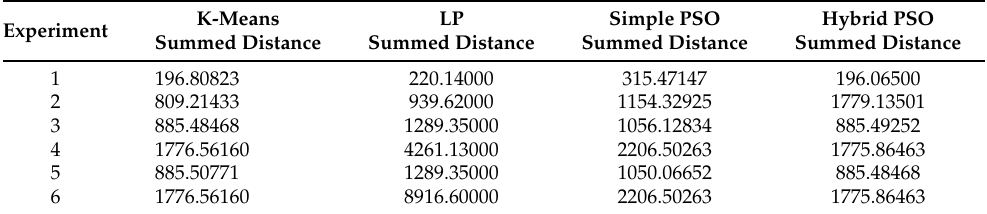
Table 17. The comparison of the total distance metric (average), considering the experiments that were performed using the same parameters.